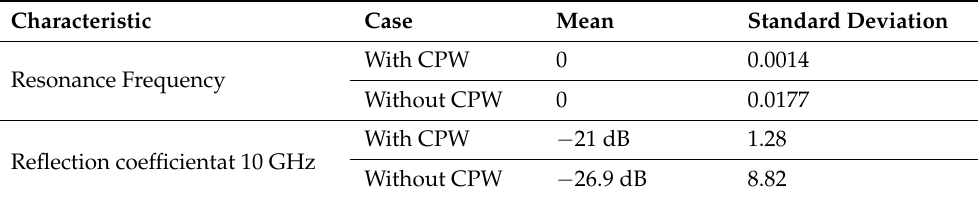
Figure 7. Histograms for durability evaluation: ( a ) resonance frequency shift; ( b ) reflection coefficient at 10 GHz. Table 2. Summarization of the durability evaluation.